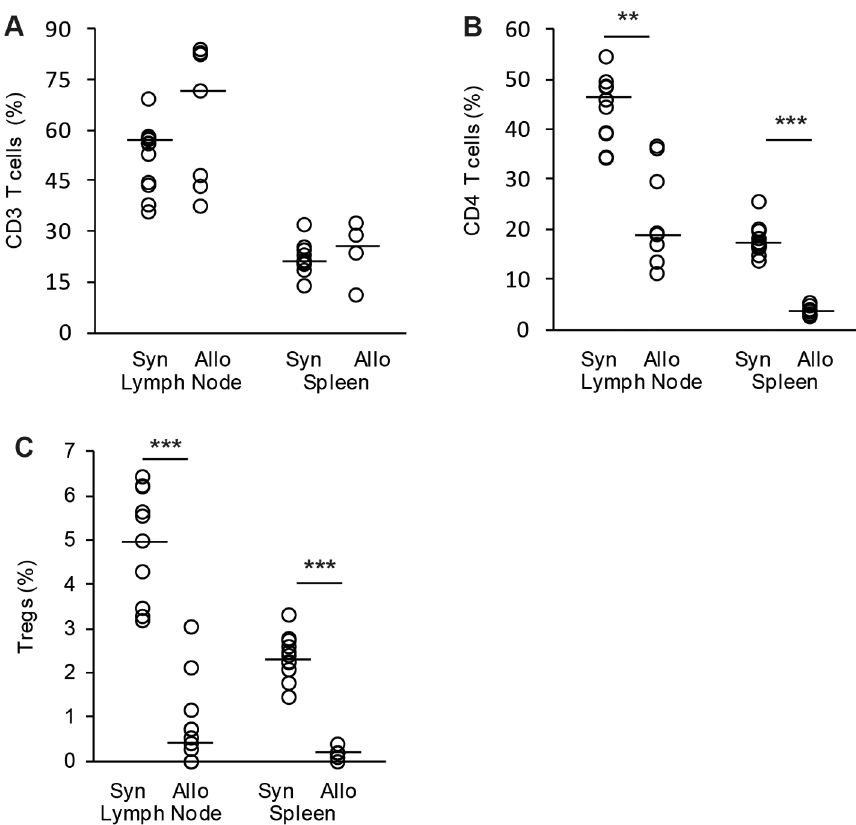
Figure 2. Evaluation of T-cell populations after syngeneic and allogeneic BMT. Analysis of T-cell subpopulations were performed after BMT in allogeneic C57BL/6 R BALB/c (Allo) vs. syngeneic control transplantations (Syn). Percentage of CD3 positive T-cells (A), CD4 positive T-helper cells (B) and CD4 CD25 FoxP3 positive regulatory T-cells (C) from all splenocytes or lymph node cells were shown. Cells were analyzed from 7 allogeneic and 11 syngeneic transplanted mice. Animals were sacrificed when reaching clinical GvHD score $ 6 or when reaching day 56 after BMT (dot-plot with median, **p , 0.01, ***p , 0.001).